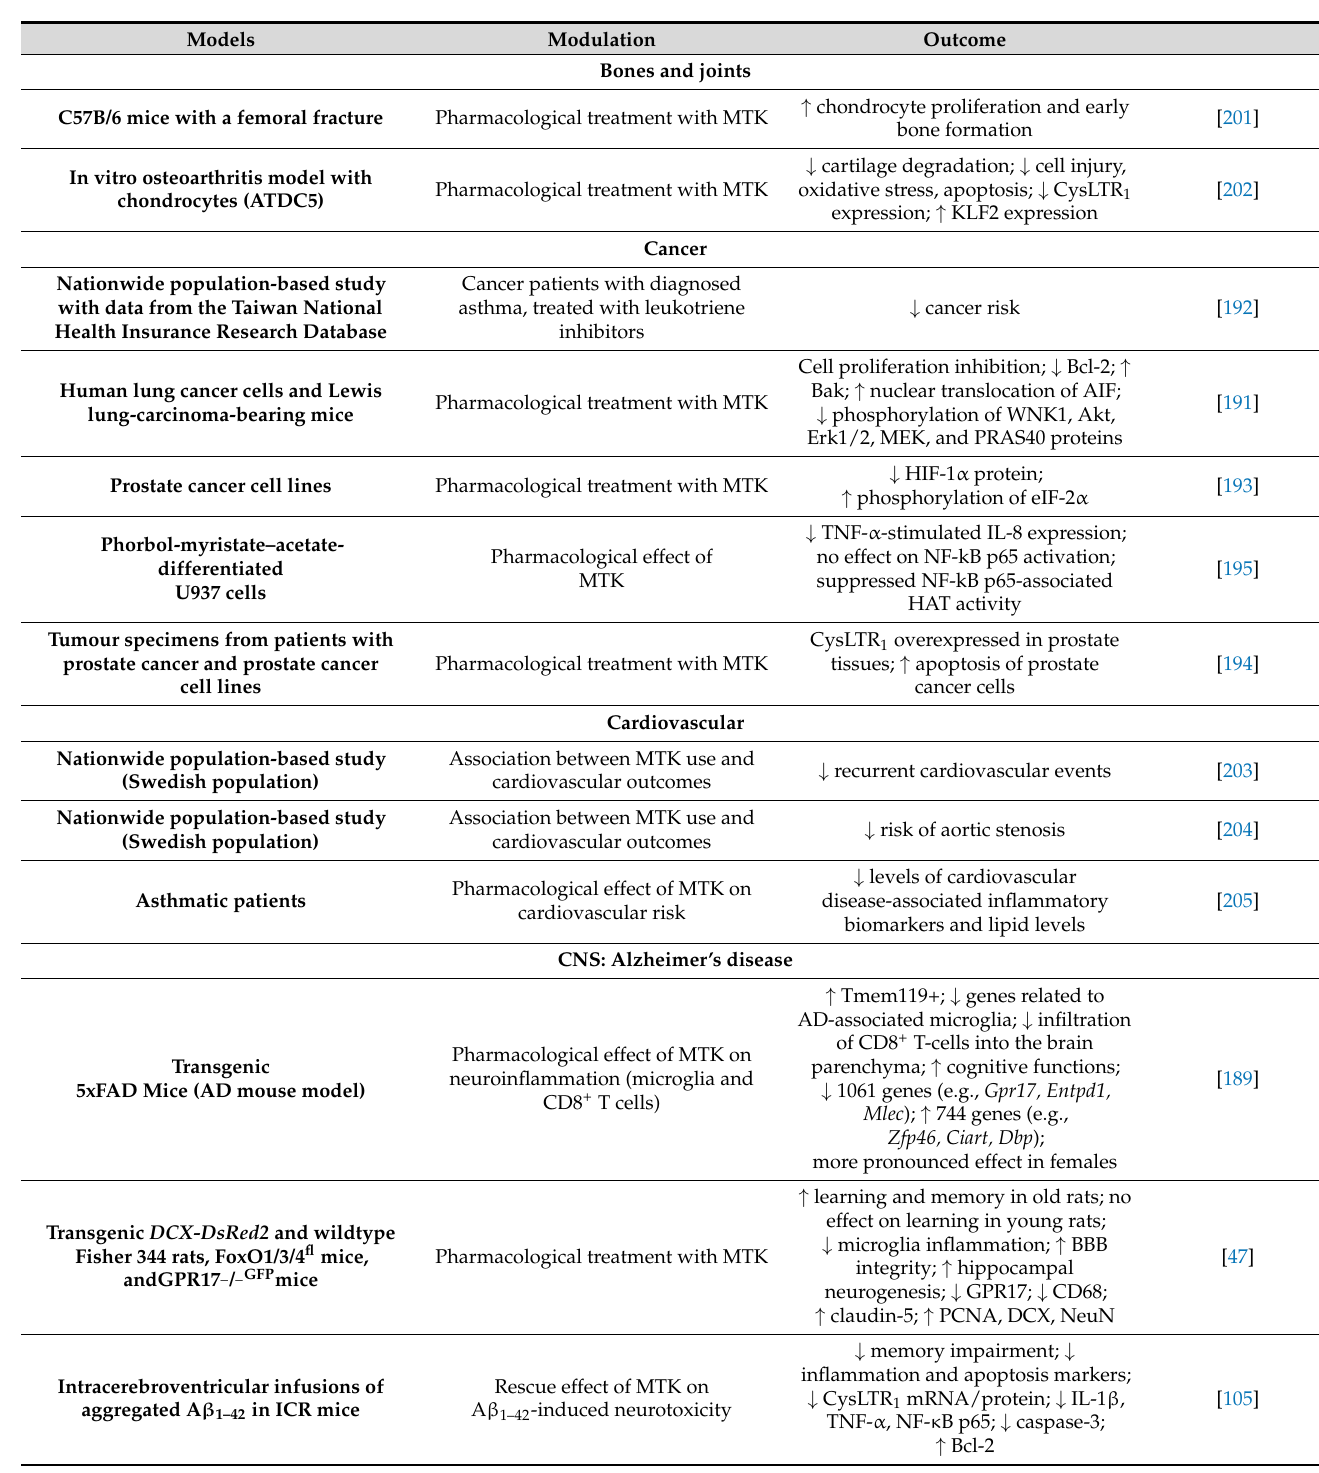
Table 2. Repurposing applications proposed for montelukast. Montelukast has been proposed for repur- posing in different therapeutic applications, including cancer, degenerative disorders, and renal